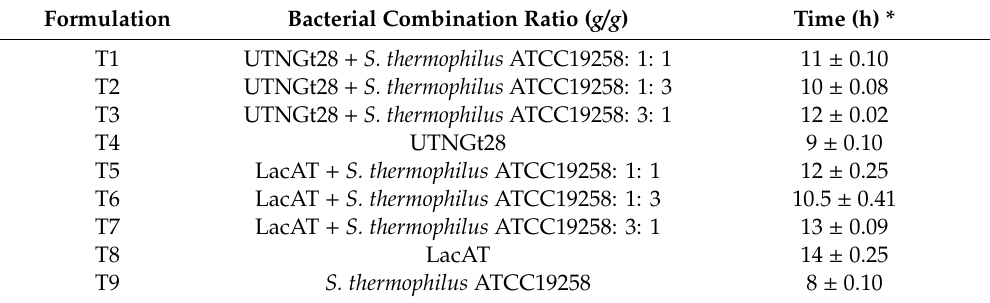
Table 2. Fermentation times to reach pH 4.5 for studied formulations for potential use in the manufacturing of